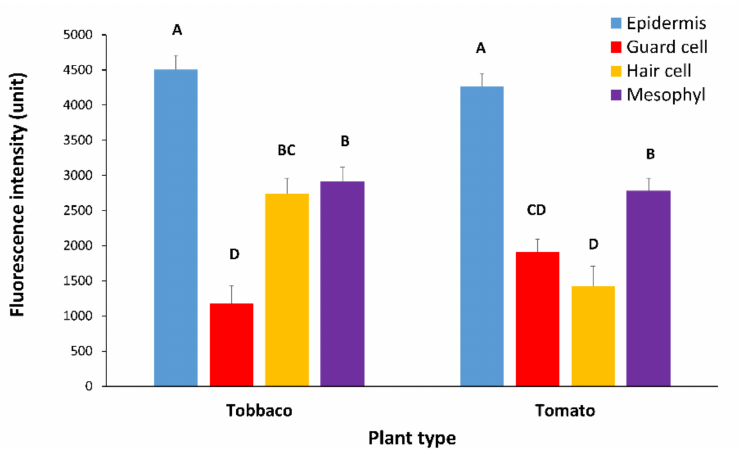
Figure 6. Fluorescence intensity of PDLP5-GFP protein in various cells in leaves of tomato and tobacco plants. Tomato and tobacco plants were transformed with 35S::PDLP5-GFP and were viewed in confocal microscopy. The intensity of GFP fluorescence in the plasmodesmata decorated with GFP per µ m of the cell wall was measured per cell type. In each graph, means ( ± SE) are shown. Different letters above the data columns mean that differences between treatments are statistically significant ( p {f} < 0.001). Each genotype was tested separately.